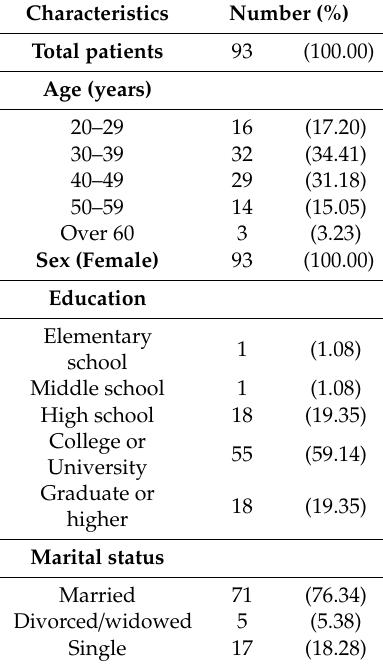
Table 2. Characteristics of the respondents (Number of female: